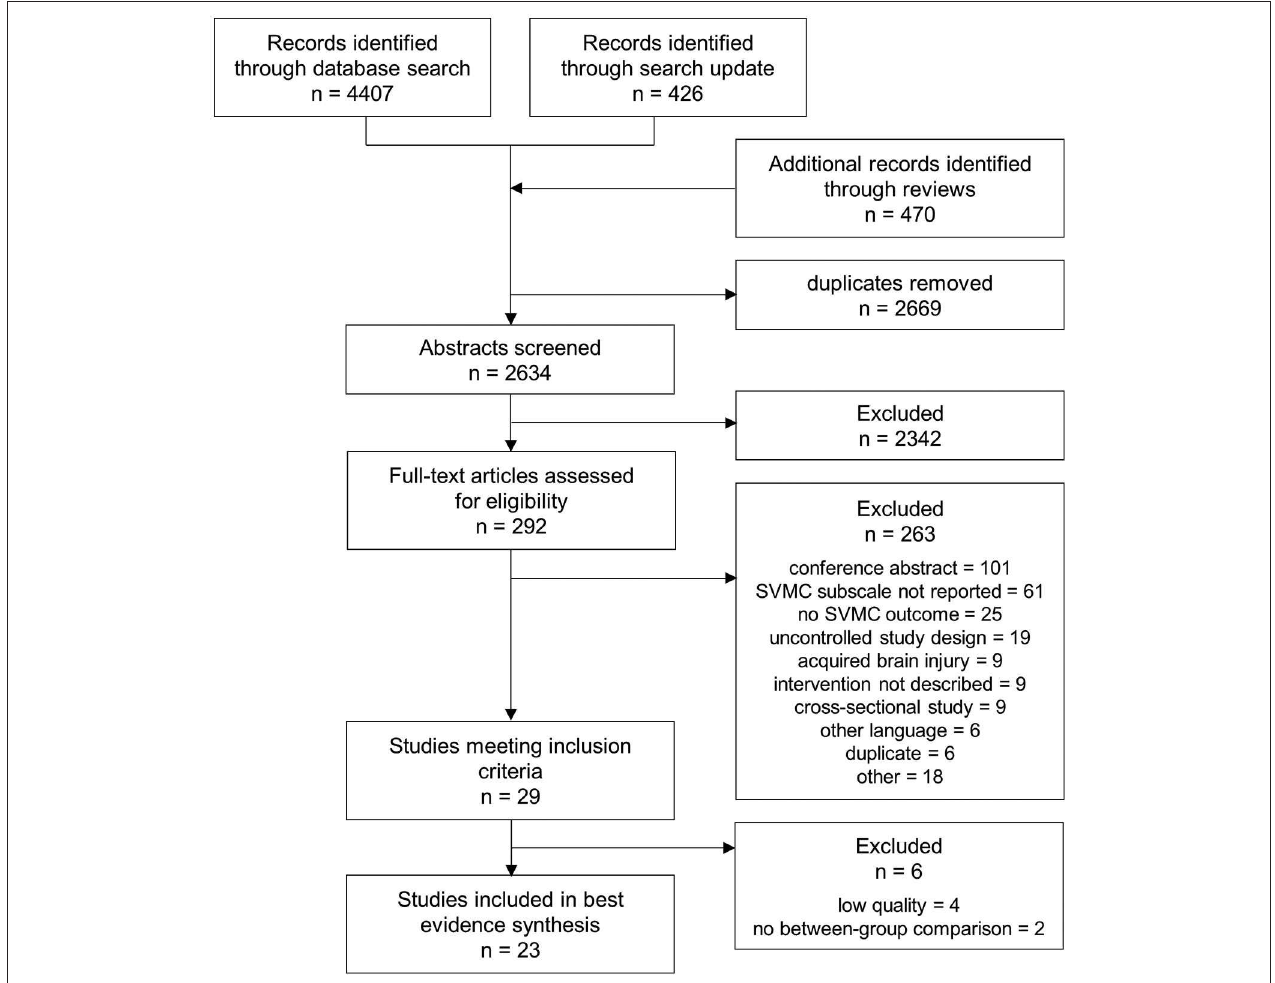
FIGURE 1 | PRISMA (Preferred Reporting Items for Systematic Reviews and Meta-Analyses) flow chart showing the process of study selection.